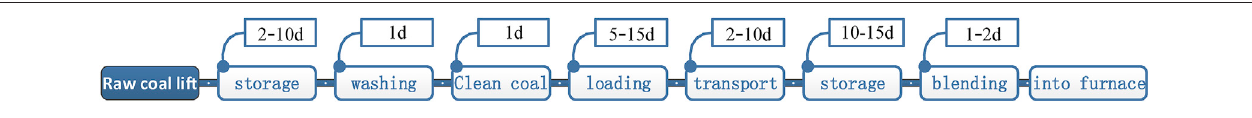
FIGURE 4 | Whole life cycle process of raw